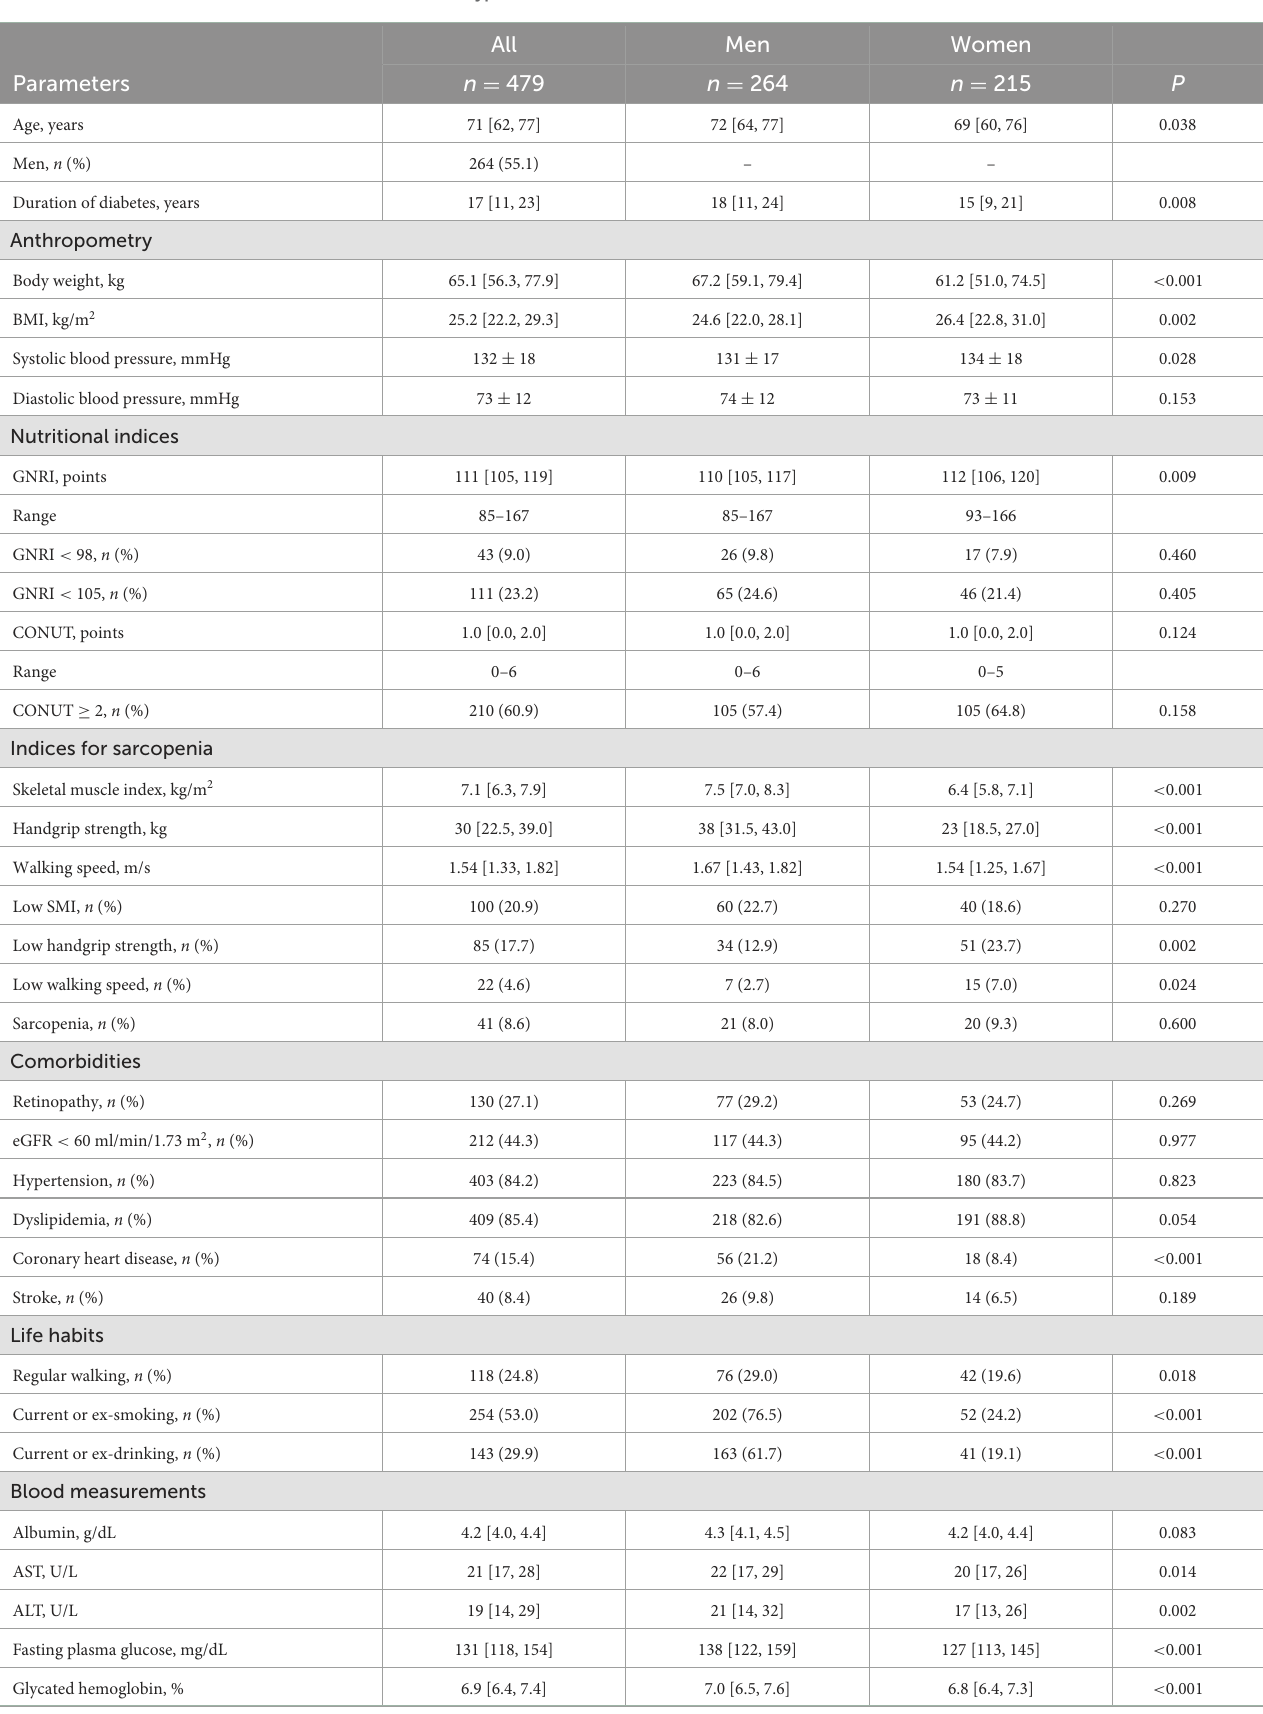
TABLE 1 General characteristics of men and women with type 2 diabetes